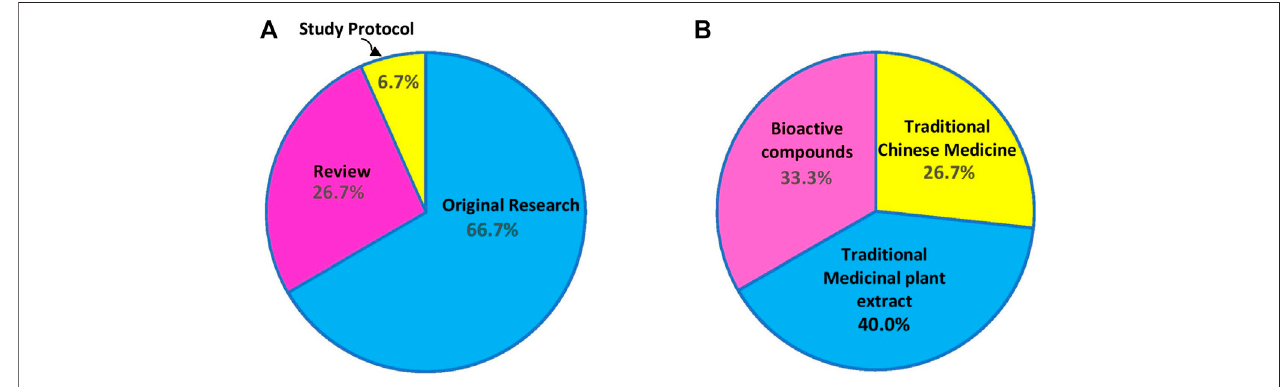
FIGURE 1 | (A) The proportion of article types and (B) the type of studied medicinal plants published in the Research